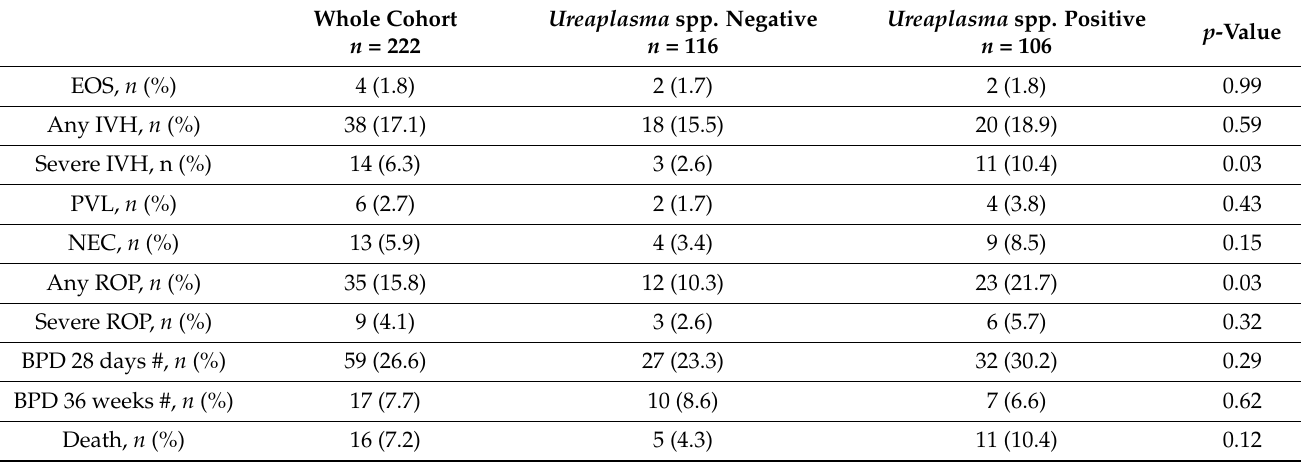
Table 2. Short-term clinical outcome of study patients according to vaginal Ureaplasma spp. colonization. Whole